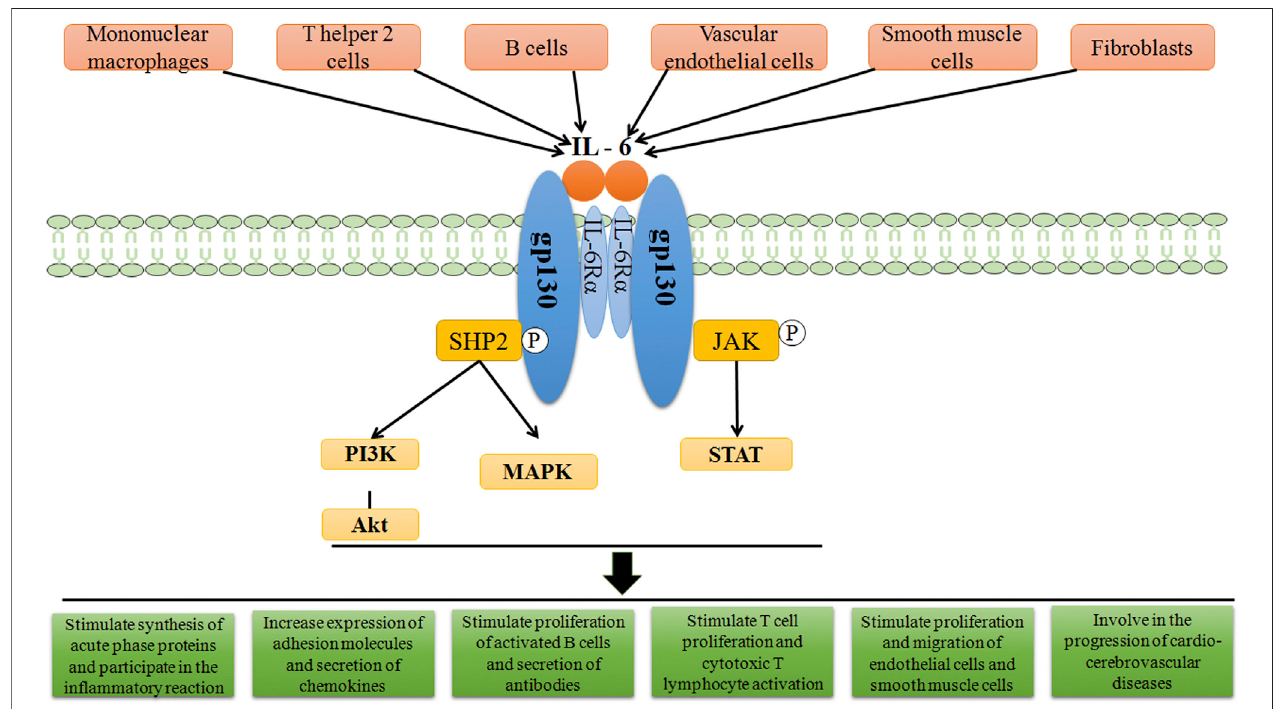
FIGURE 1 | Schematic representation of IL-6 signal transduction. On target cells, IL-6 fi rst binds to IL-6R α , and subsequently associates with cellular membrane boundgp130,inturninducinggp130dimerizationandinitiationofIL-6intracellularsignalling.FormationoftheIL-6/IL-6R α /gp130complexinducesautophosphorylation and activation of the gp130-associated JAKs. These activated JAKs phosphorylate tyrosine residues within the cytoplasmic portion of gp130. Phosphorylation of the membrane-proximal tyrosine residue, leads to the recruitment of SHP2, which then stimulates the activation of MAPK and PI3K pathways. After the activation of JAKs, STAT molecules are recruited and then phosphorylated by the JAKs. The related down-stream proteins translocate afterwards into the nucleus to activate gene transcription, thereby playing the corresponding roles.